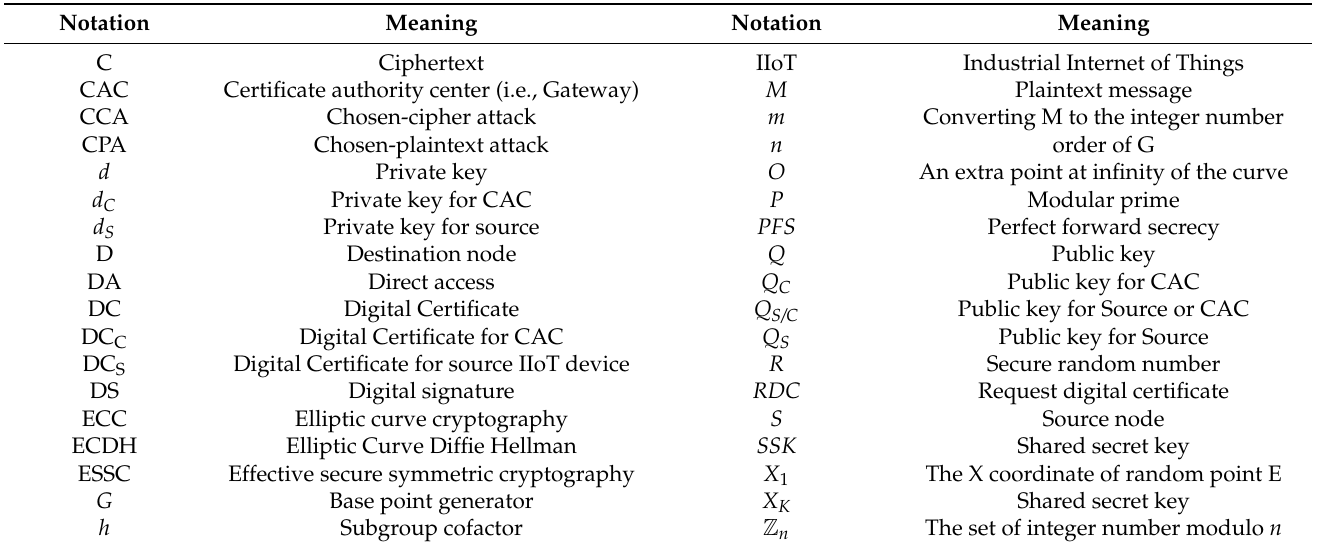
Table 2. Frequently used